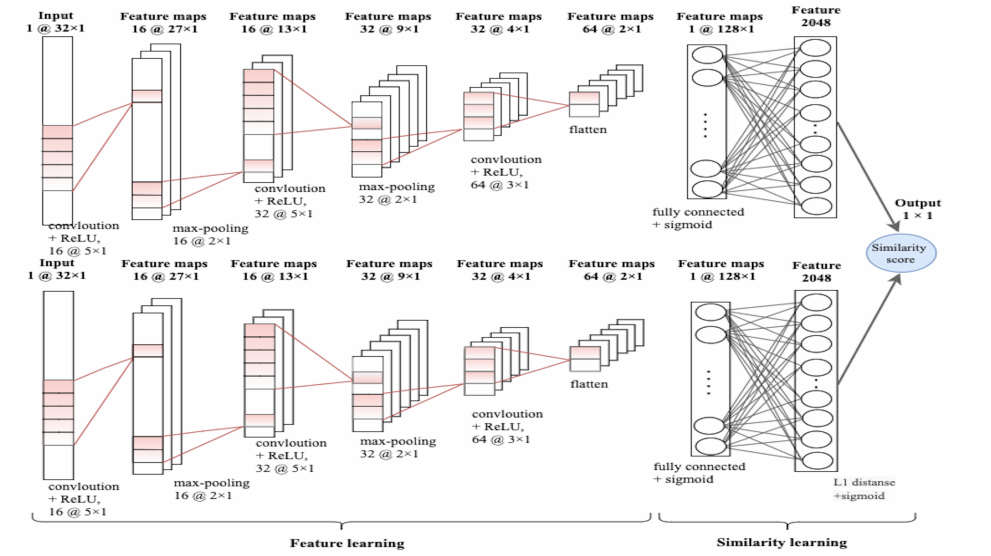
Figure 2. Our convolutional Siamese neural network